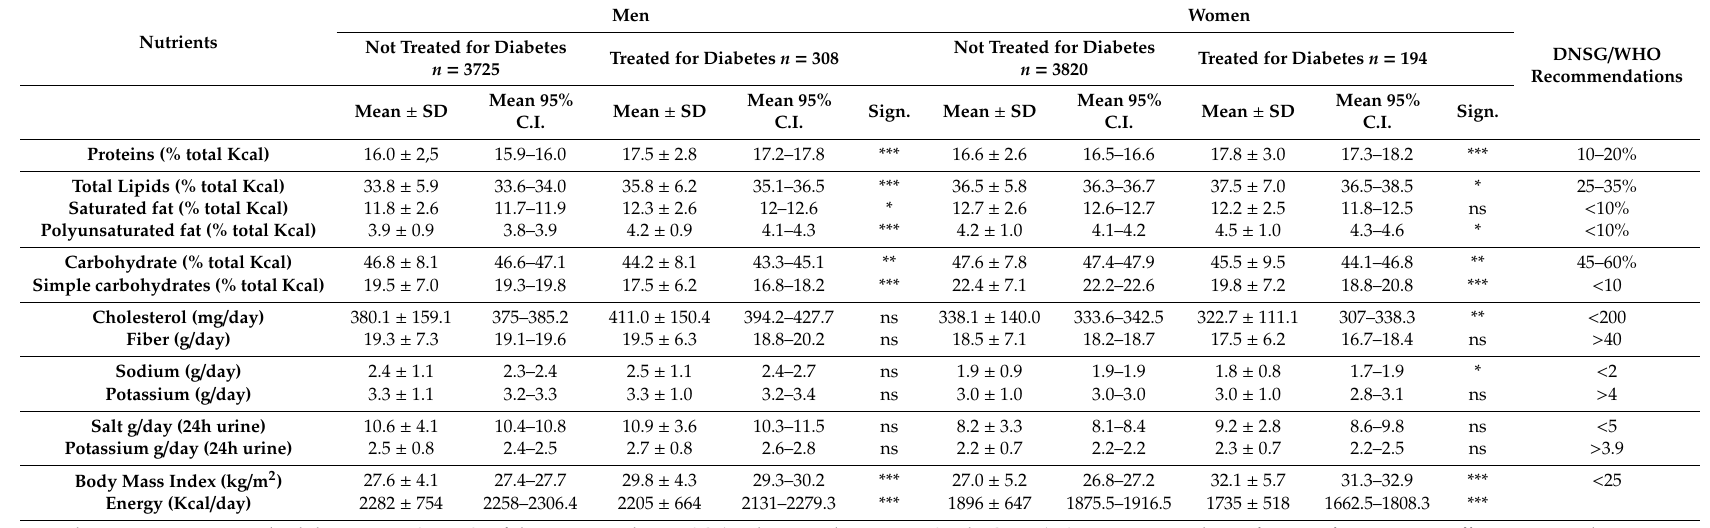
Table 3. Nutrients composition of the diet in men and women receiving and not receiving treatment for diabetes. Men and women aged 35–79 years from the Osservatorio Epidemiologico Cardiovascolare / Health Examination Survey of the CUORE Project